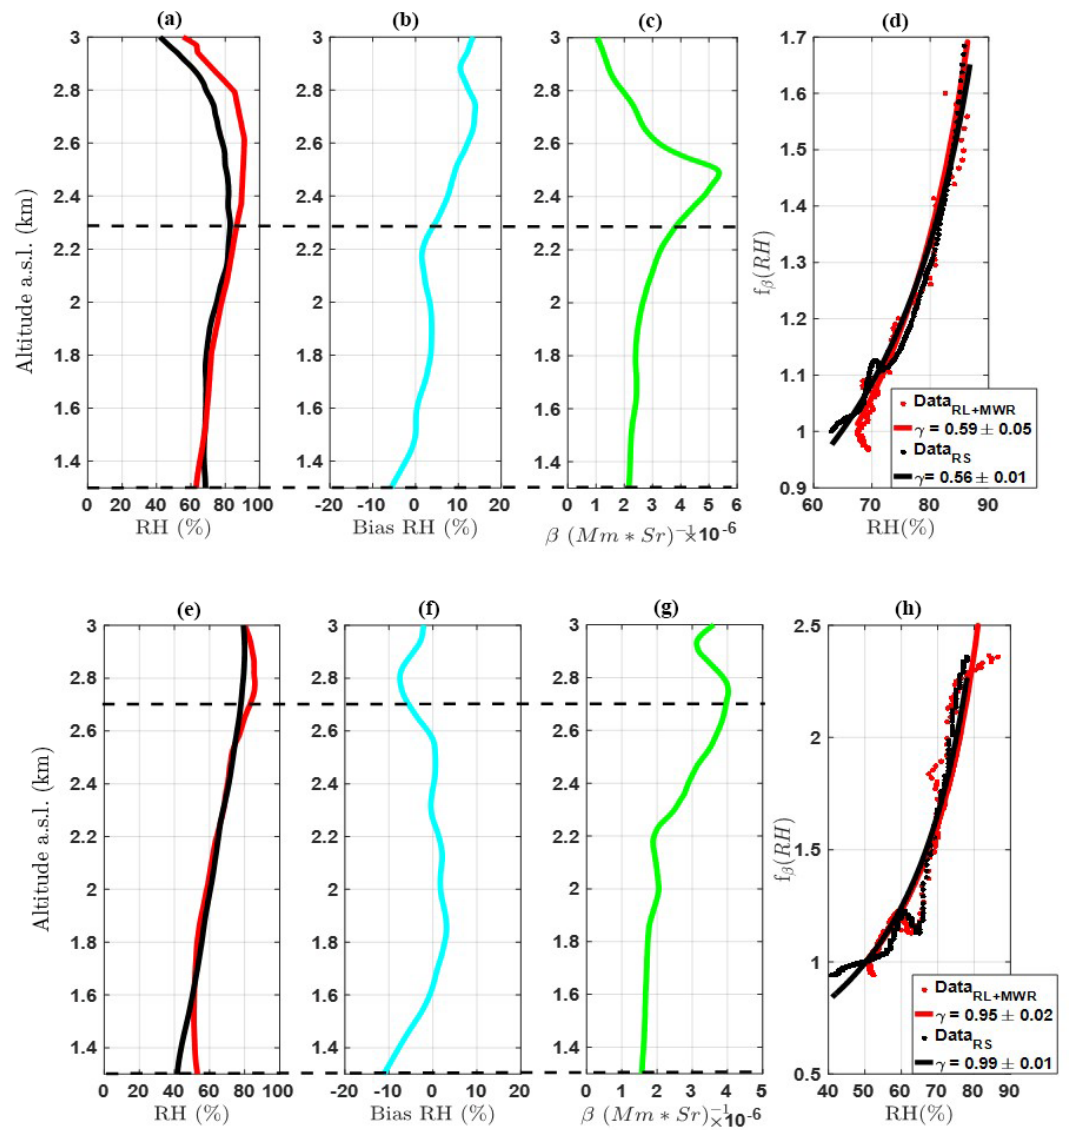
Figure 3. (a, e) Profiles of RH retrieved from RS (black line) and by the synergy RL + MWR (red line), (b, f) RH bias profiles (cyan line), (c, g) β par retrieved by using the Klett–Fernald algorithm and lidar ratio of 65Sr (green line), and (d, f) f β (RH) calculated for RS (black dots) and by the synergy RL + MWR (red dots) and the corresponding Hänel parameterizations (solid lines), where the red line refers to the RL + MWR method (case I: γ = 0 . 59 ± 0 . 05, case II: γ = 0 . 95 ± 0 . 02) and the black line refers to the RS method (case I: γ = 0 . 56 ± 0 . 01, case II: γ = 0 . 99 ± 0 . 01). The top row corresponds to case I (22 July 2011, 20:30–21:00UTC) and the bottom row to case II (22 July 2013, 20:00–20:30UTC). Horizontal dashed lines indicate the altitude range analyzed for each case (1.3 to 2.3km for case I and 1.3 to 2.7km for case II). All these profiles were measured at the EARLINET IISTA-CEAMA